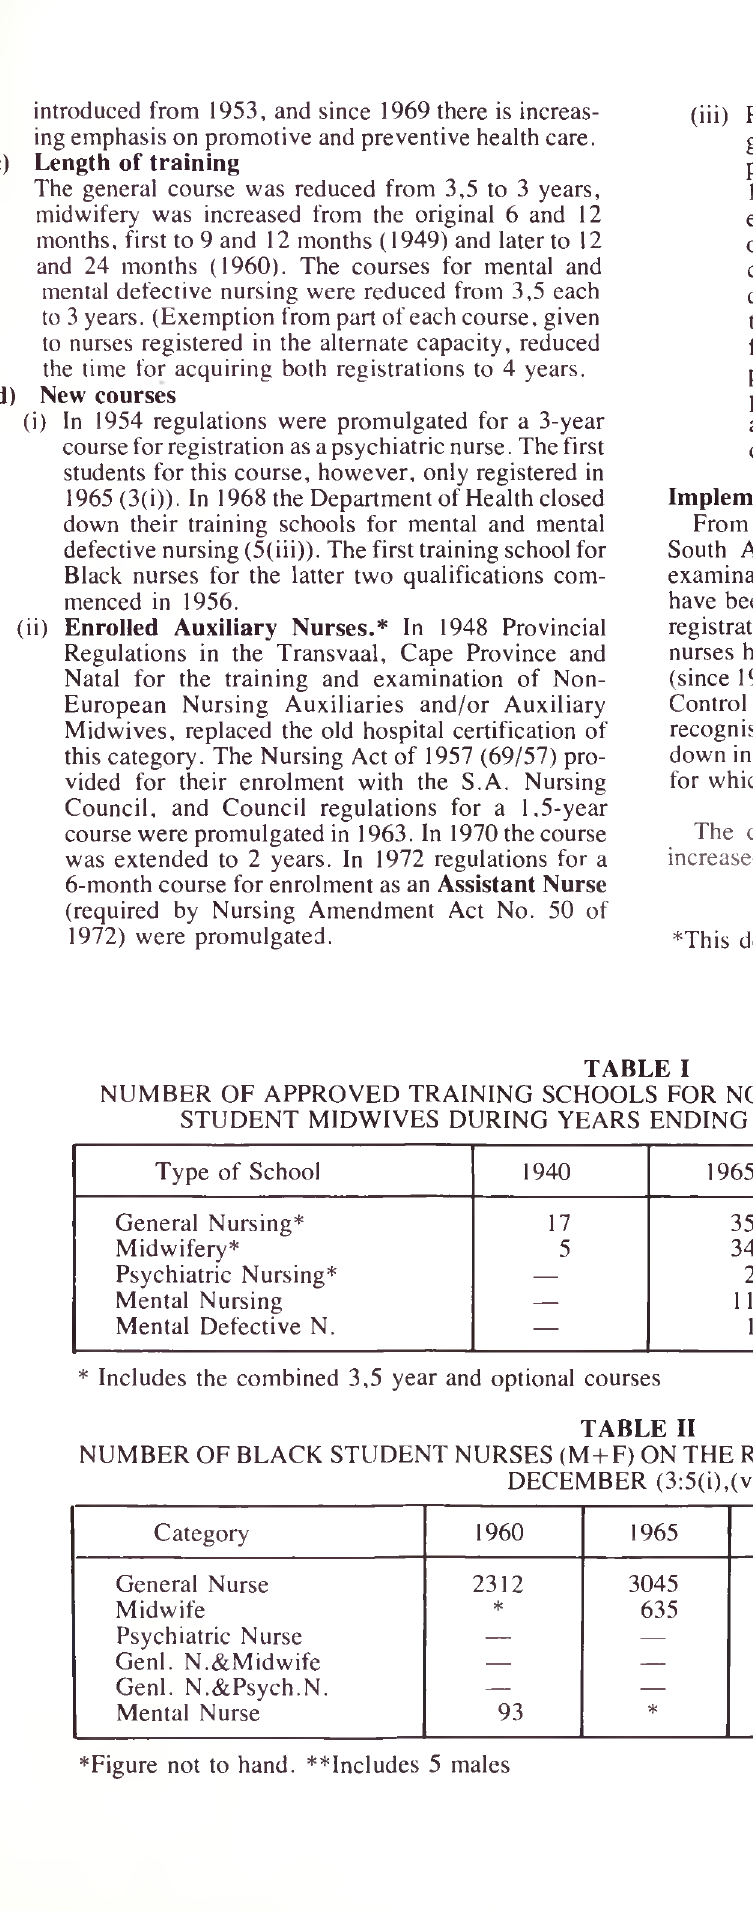
*Figure not to hand. **Includes 5